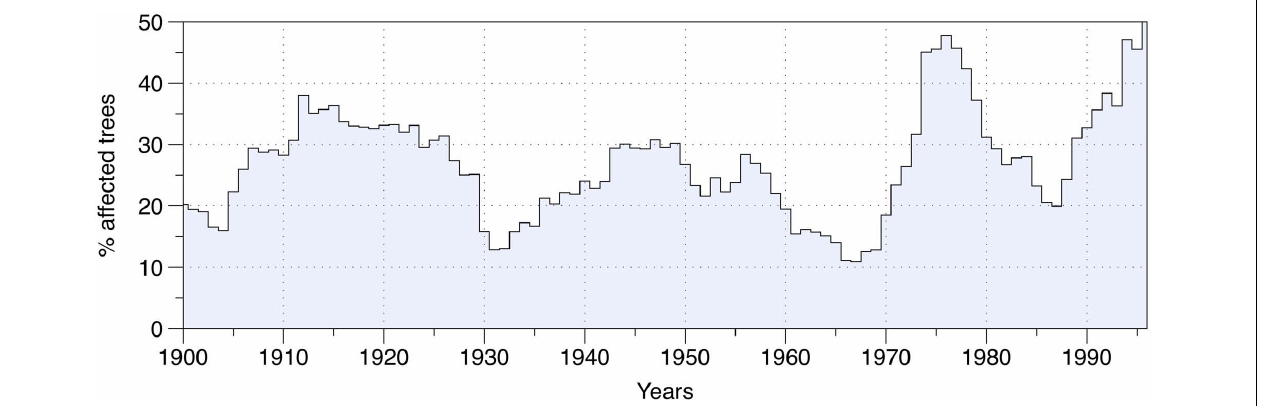
FIGURE 2 | The proportion of trees affected by outbreak conditions in the study